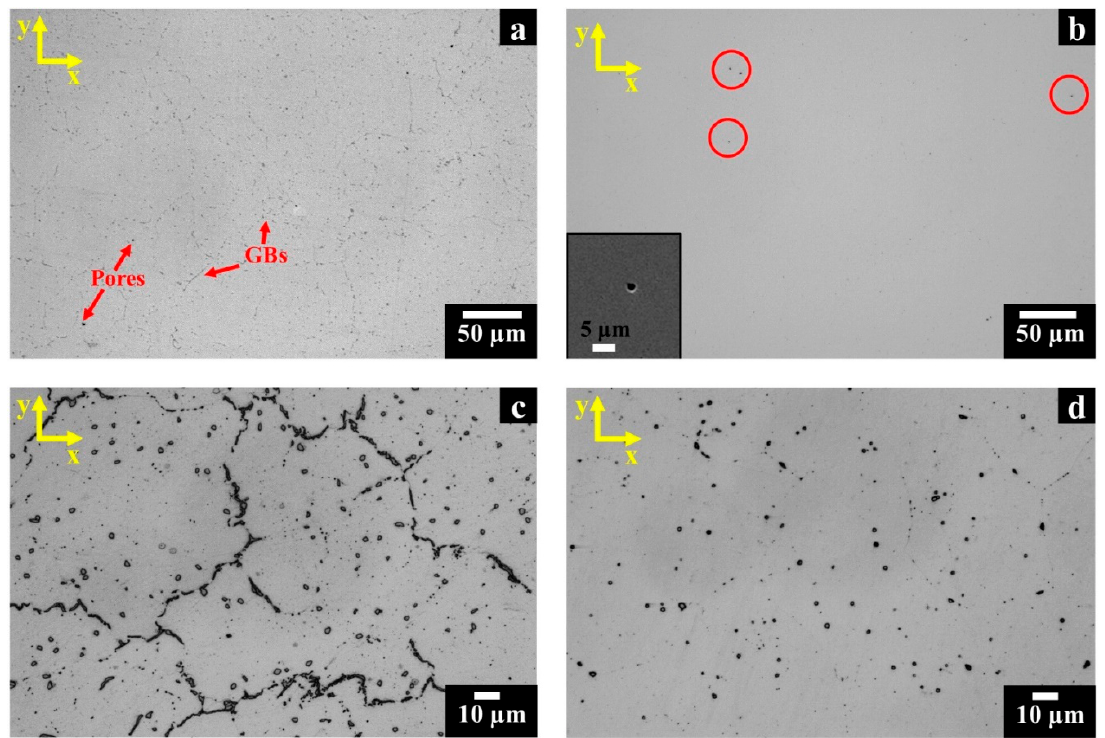
Figure 3. LOM images of polished post-processed HX samples along the x-y plane: ( a ) HIPed state showing pores and carbides along the grain boundaries (GBs); ( b ) post-solution annealed state exhibiting very fine isolated pores as highlighted by the SEM image in the inset; ( c ) HIPed state showing film of intergranular carbides and globular and square intragranular carbides; ( d ) post-solution annealed state exhibiting only globular and square inter/intragranular carbides.